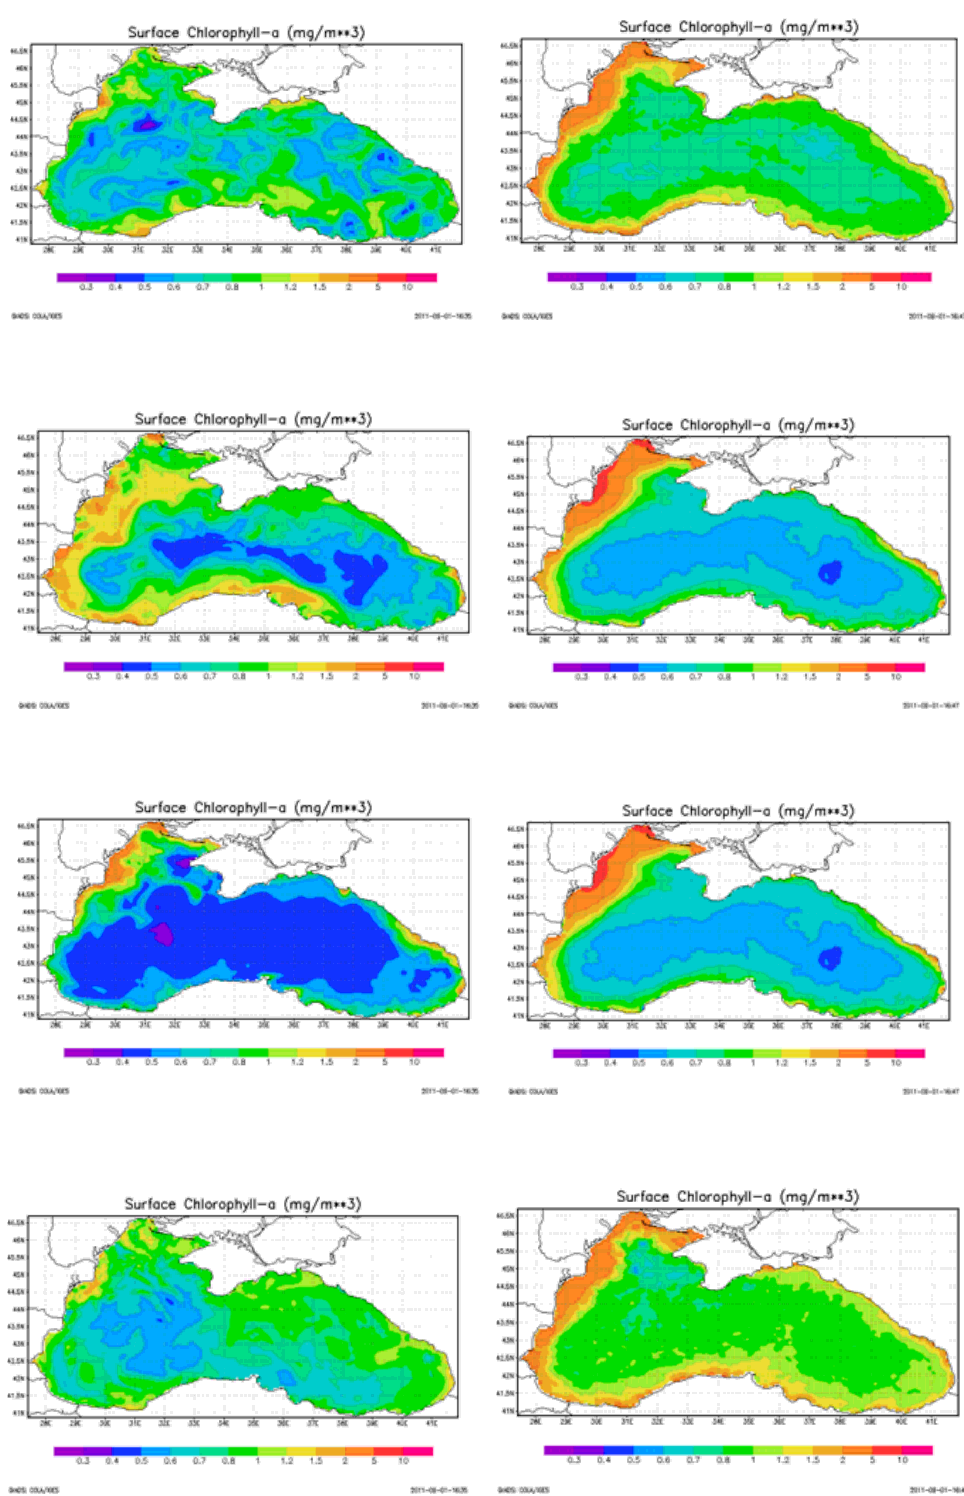
Fig. 23. Maps of the surface chlorophyll-a derived from the model (left panel) and MODIS climate data, which correspond to winter, spring, summer and autumn (from top to